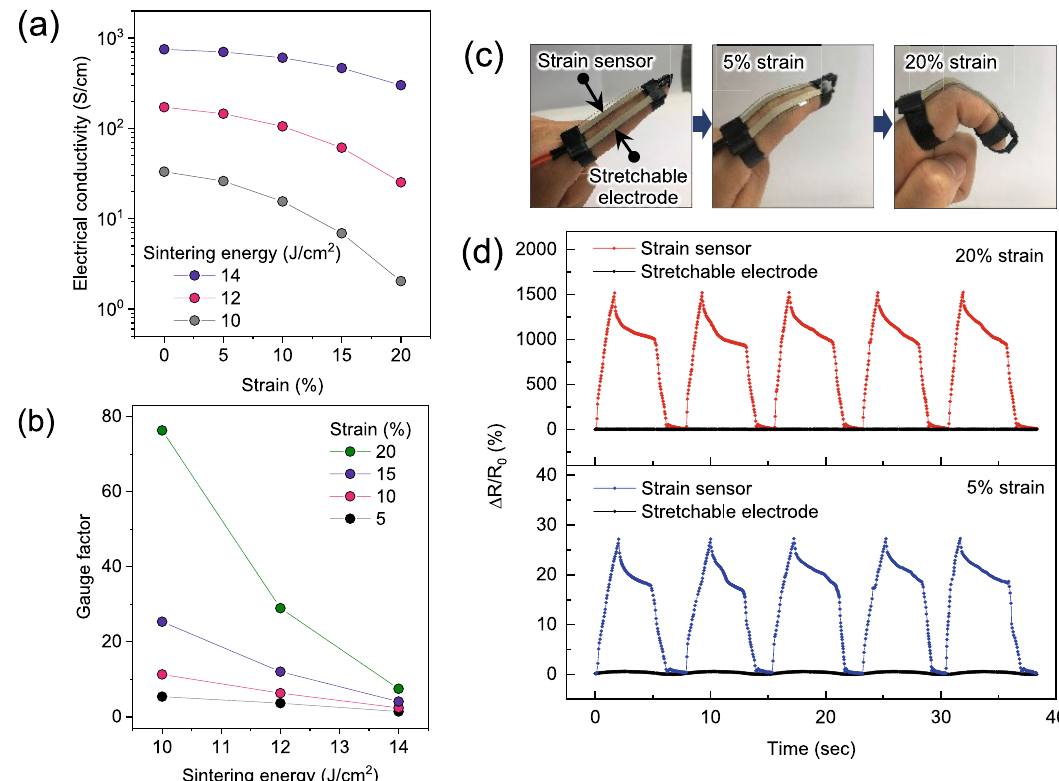
Figure 5. ( a ) Electrical conductivity and ( b ) calculated gauge factor for the composite films with respect to the sintering energy and strain. ( c ) Photographs of the stretchable electrode and strain sensor fabricated with the same PDMS substrate subjected with 5% and 20% strain and ( d ) their relative resistivity change profile for 5 times repeating